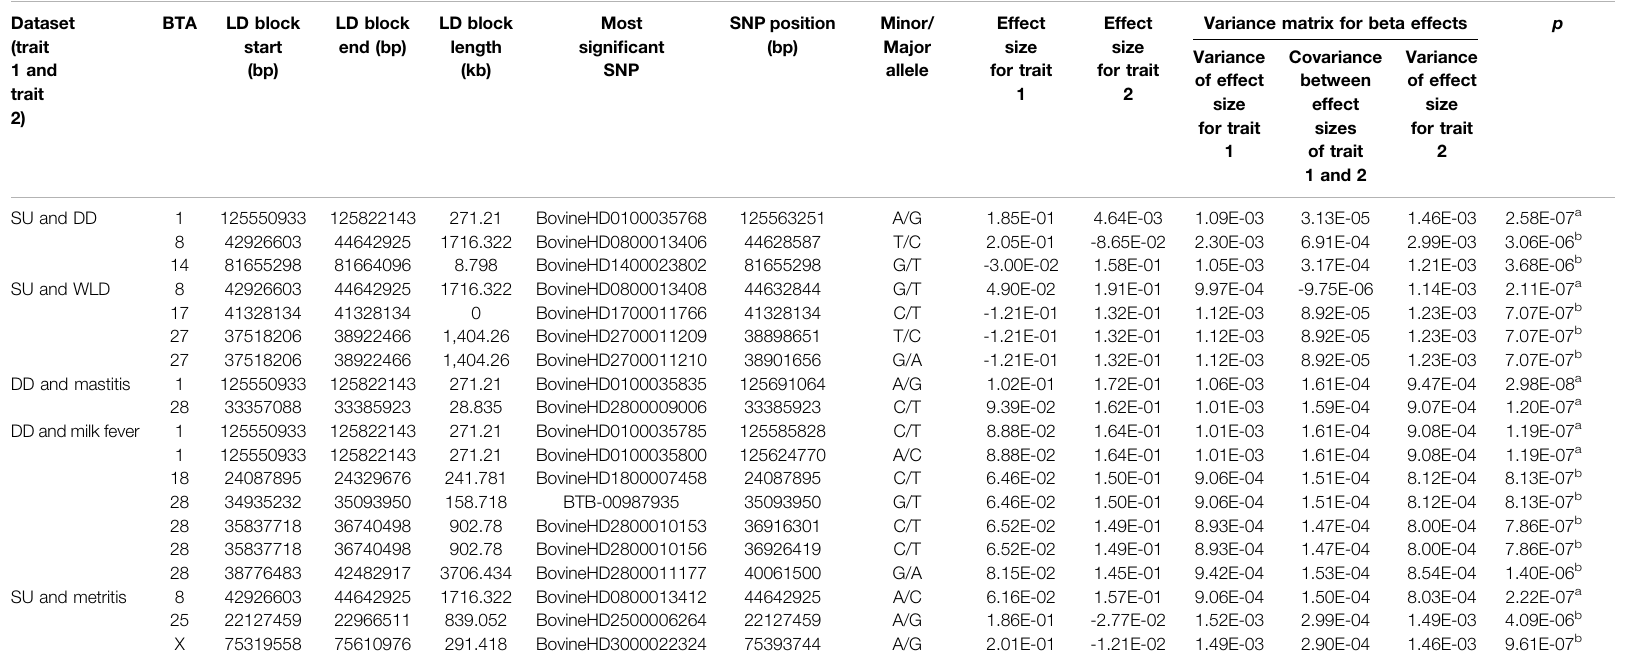
TABLE 3| Linkage disequilibrium (LD) blocks and themost signi fi cantSNP within the LDblock de fi ned from thetwo-trait genome-wide association analyses ofsole ulcer (SU), whitelinedisease (WLD), and digital dermatitis (DD) paired with each other and other health disorders. Dataset